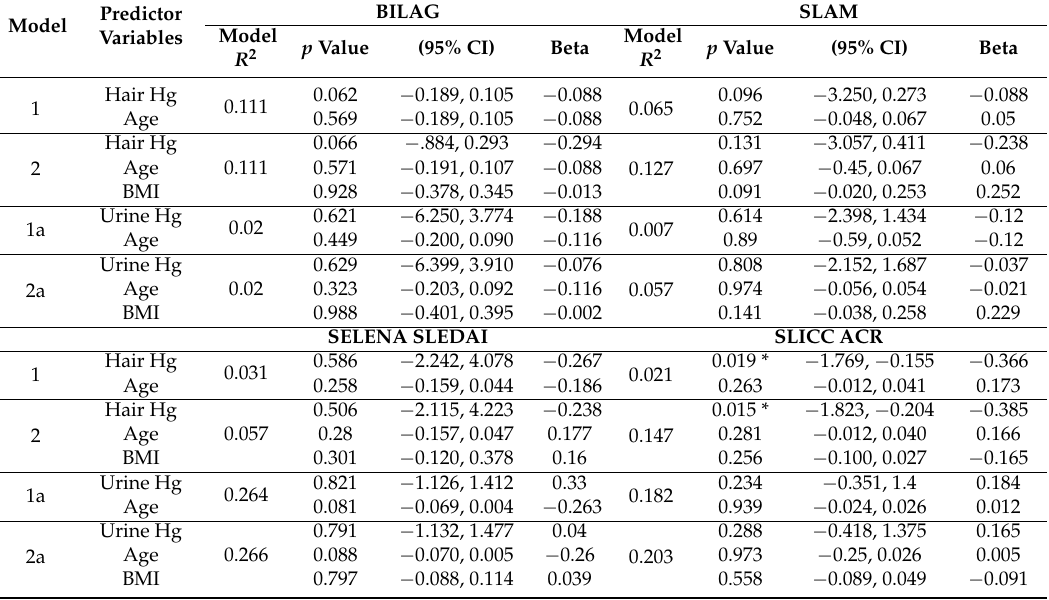
Table 3. The relationship between urine and hair Hg and measures of disease activity and damage in SLE ( n =